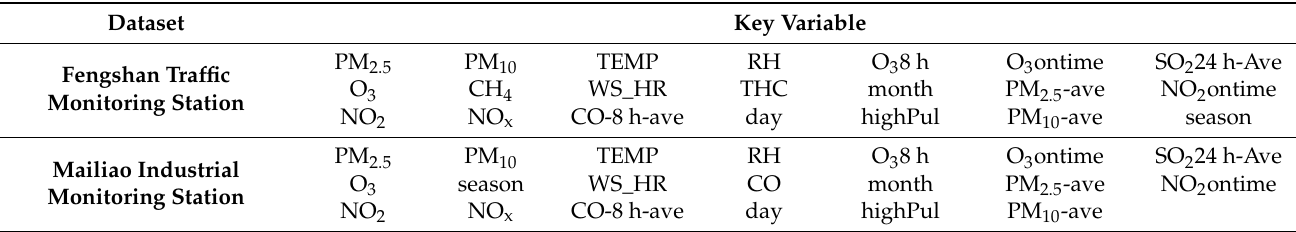
Table 4. Results of selected key variables by